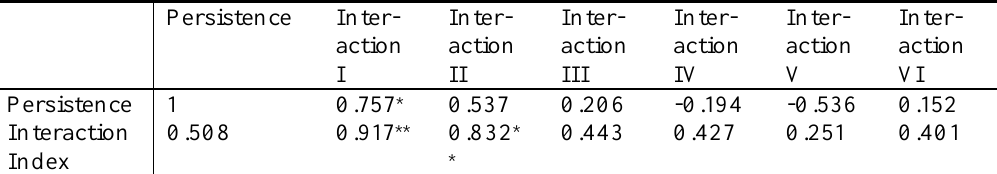
Correlation Coefficient Between Six Types of Instructional Interactions, Interaction Index and the Rate of